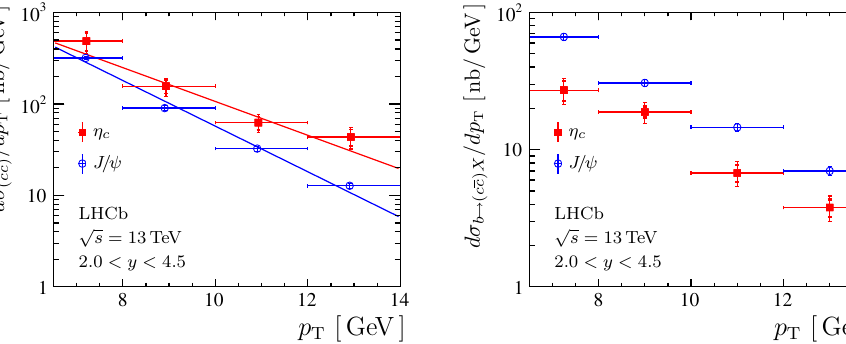
fractions and J /ψ production cross-section. For the prompt production cross-sections, the results of fits with an exponential function are over- laid. The p T values of the data points correspond to the average values of the fit function over the